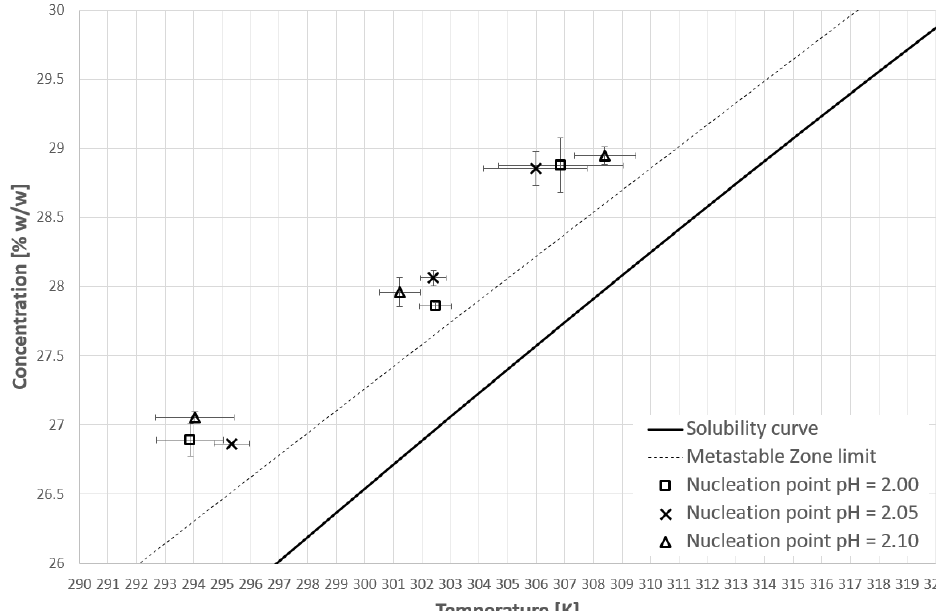
Figure 7. Nucleation point temperatures for the first cooling cycle.